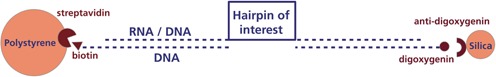
Schematic representation of a molecular construct linked to functionalized beads. A DNA (resp. RNA) hairpin is inserted between two DNA/DNA (resp. RNA/DNA) handles. Each handle has a crystallographic length of about 0.5 μm (resp. 0.4 μm).